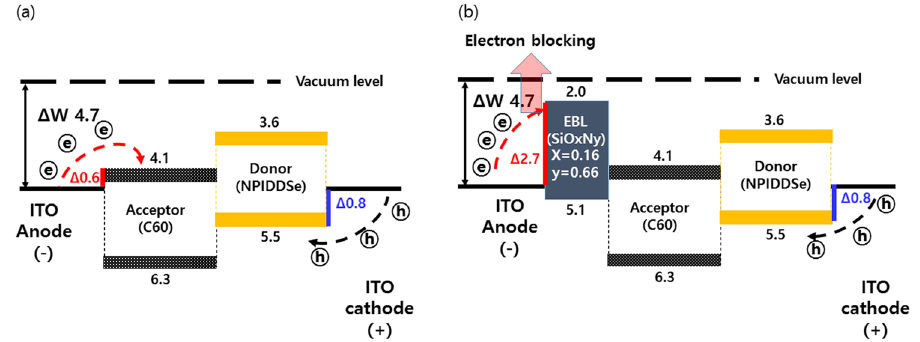
Figure 5. ( a ) and ( b ) Re-plots the full band diagram of without SiO x N y (S1 sample, ITO/naphthalen based donor:C60(1:1)/ITO structure) and with SiO Fig. 3.